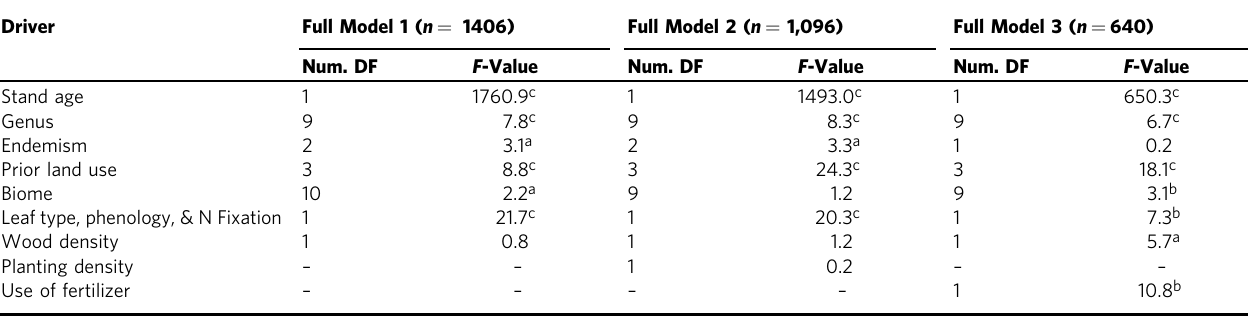
Table 2 Results of comparative models across